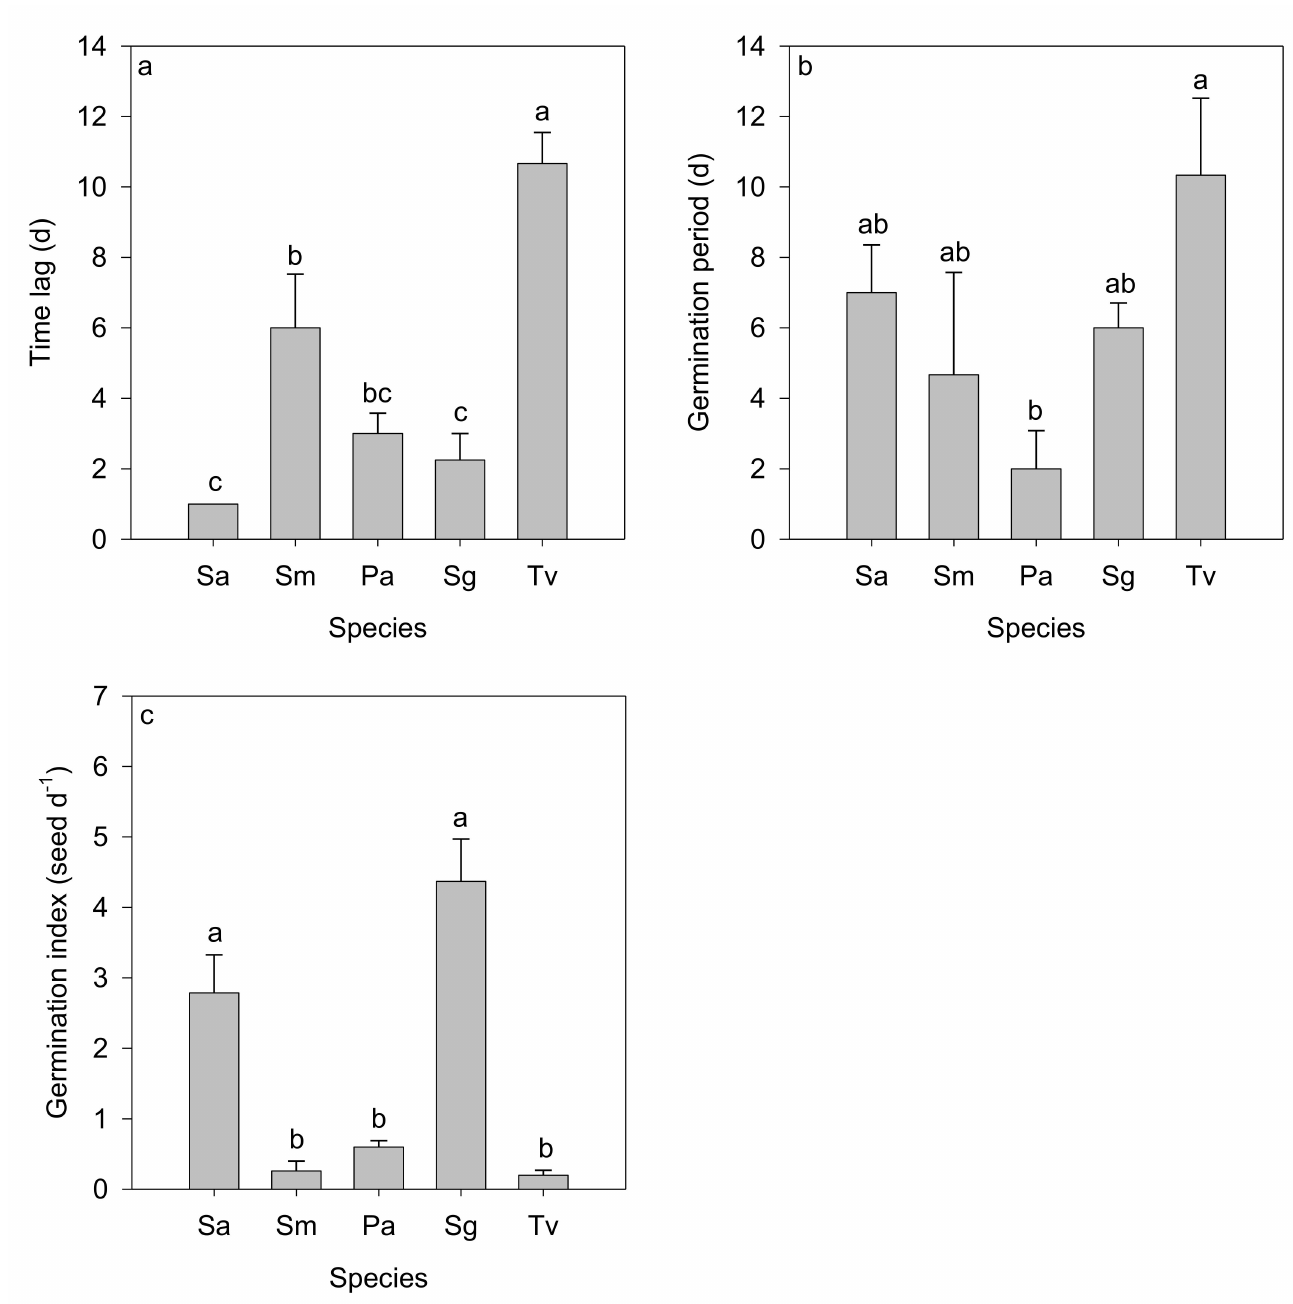
Figure 1. Germination traits of invasive Spartina alterniflora (Sa) and four native species ( Scirpus mariqueter , Sm, Phragmites australis , Pa, Suaeda glauca , Sg, and Tripolium vulgare , Tv) in control treatment (target species in monoculture). ( a ) Time lag before first germination, ( b ) Germination period from the first germination to the last germination, ( c ) Germination index. Different lower cases denote significant differences among different species. Error bars are standard